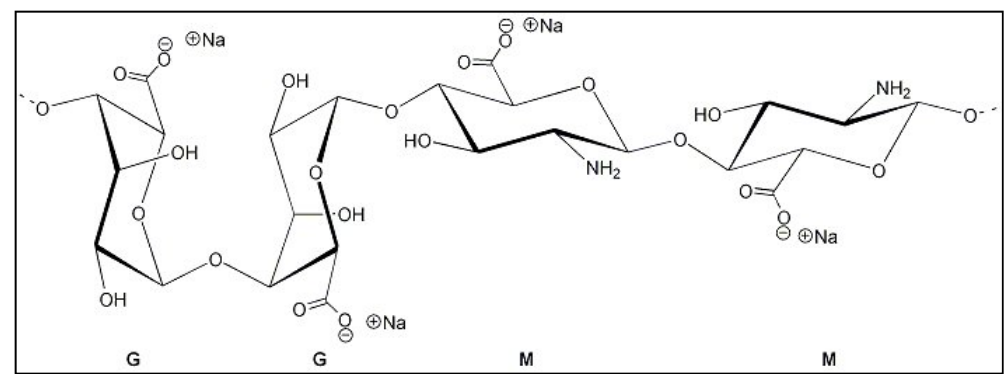
Figure 1. Structural formula of sodium alginate